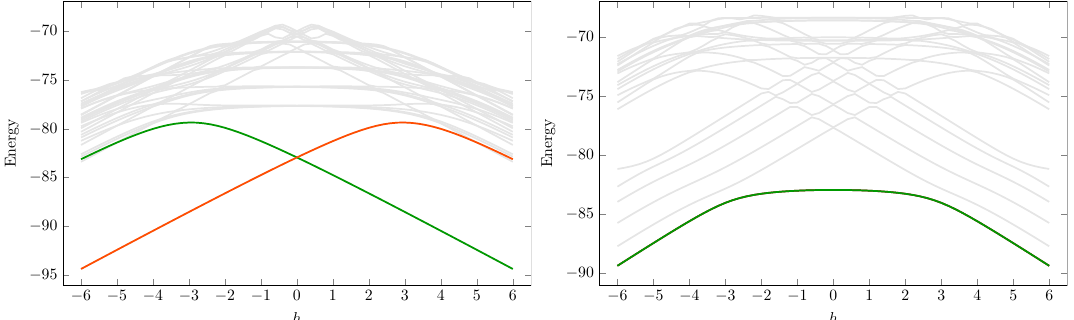
Figure 14: Lowest part of the spectrum from numerical exact diagonalization for a chain of odd length. Left : Parallel boundary fields ( h = h ± ). The red line has m = + 1 / 2, the green one, m = − 1 / 2. Right : Anti-parallel boundary fields ( h = h − = − h + ), where all states are doubly degenerate. For a chain of ∆ = 4 and L =